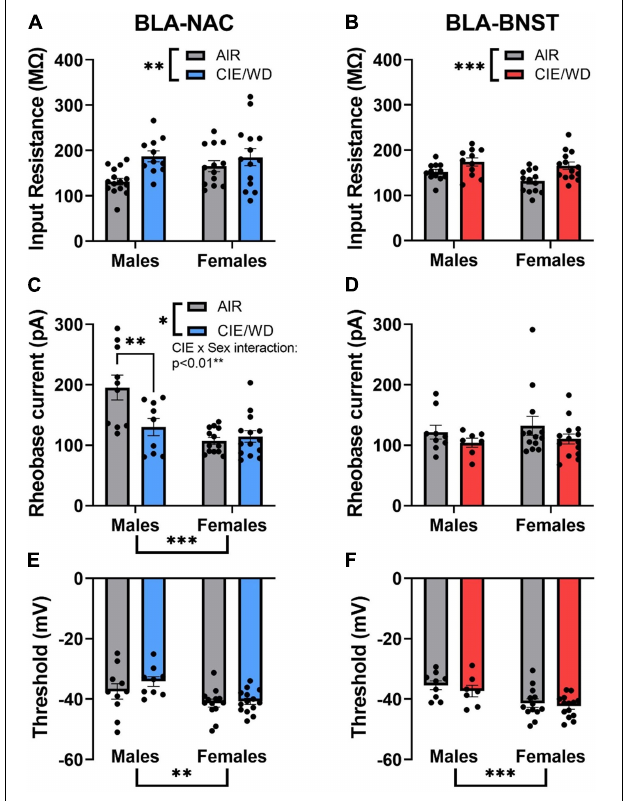
FIGURE 6 | Circuit-dependent mechanisms of enhanced excitability. (A) CIE/WD increased input resistance in BLA-NAC neurons (Males: n = 15 AIR, 11 CIE/WD; Females: n = 13 AIR, 14 CIE/WD). (B) CIE/WD increased input resistance in BLA-BNST neurons (Males: n = 12 AIR, 11 CIE/WD; Females: n = 13 AIR, 14 CIE/WD). (C) Female BLA-NAC neurons had a lower rheobase current than males and CIE/WD decreased the rheobase current in male BLA-NAC neurons (Males: n = 10 AIR, 9 CIE/WD; Females: n = 13 AIR, 14 CIE/WD). (D) CIE/WD did not affect the rheobase current in BLA-BNST neurons (Males: n = 9 AIR, 7 CIE/WD; Females: n = 13 AIR, 14 CIE/WD). (E) Female BLA-NAC neurons had a lower action potential threshold than males (Males: n = 10 AIR, 9 CIE/WD; Females: n = 13 AIR, 14 CIE/WD). (F) Female BLA-BNST neurons had a lower action potential threshold than males (Males: n = 9 AIR, 7 CIE/WD; Females: n = 13 AIR, 14 CIE/WD). Data analyzed by 2-way ANOVAs. ∗∗∗ p < 0.001, ∗∗ p < 0.01, ∗ p <